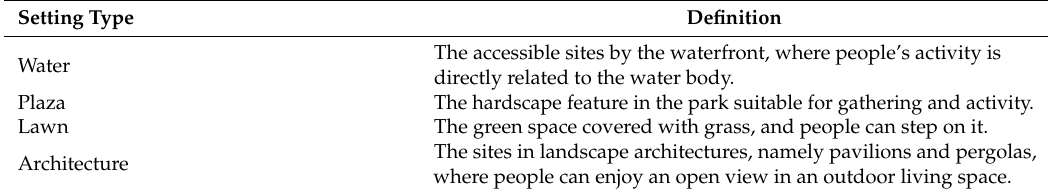
Table 1. Definitions for the behavior settings.